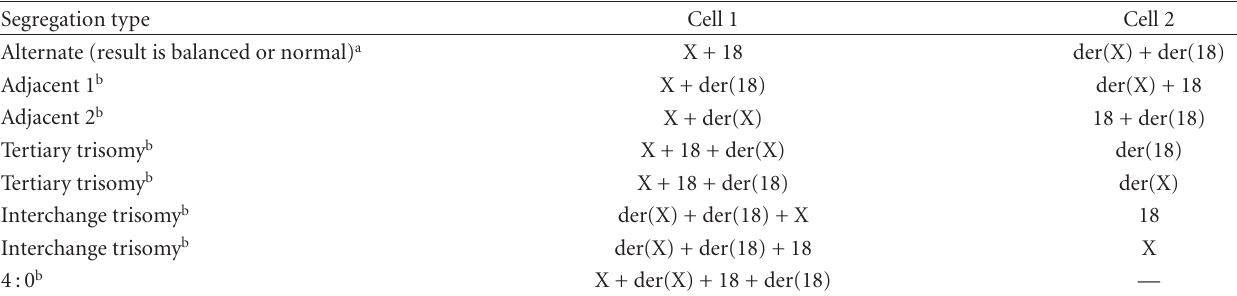
Table 1: Theoretical meiotic segregation patterns for translocation: 46, X,